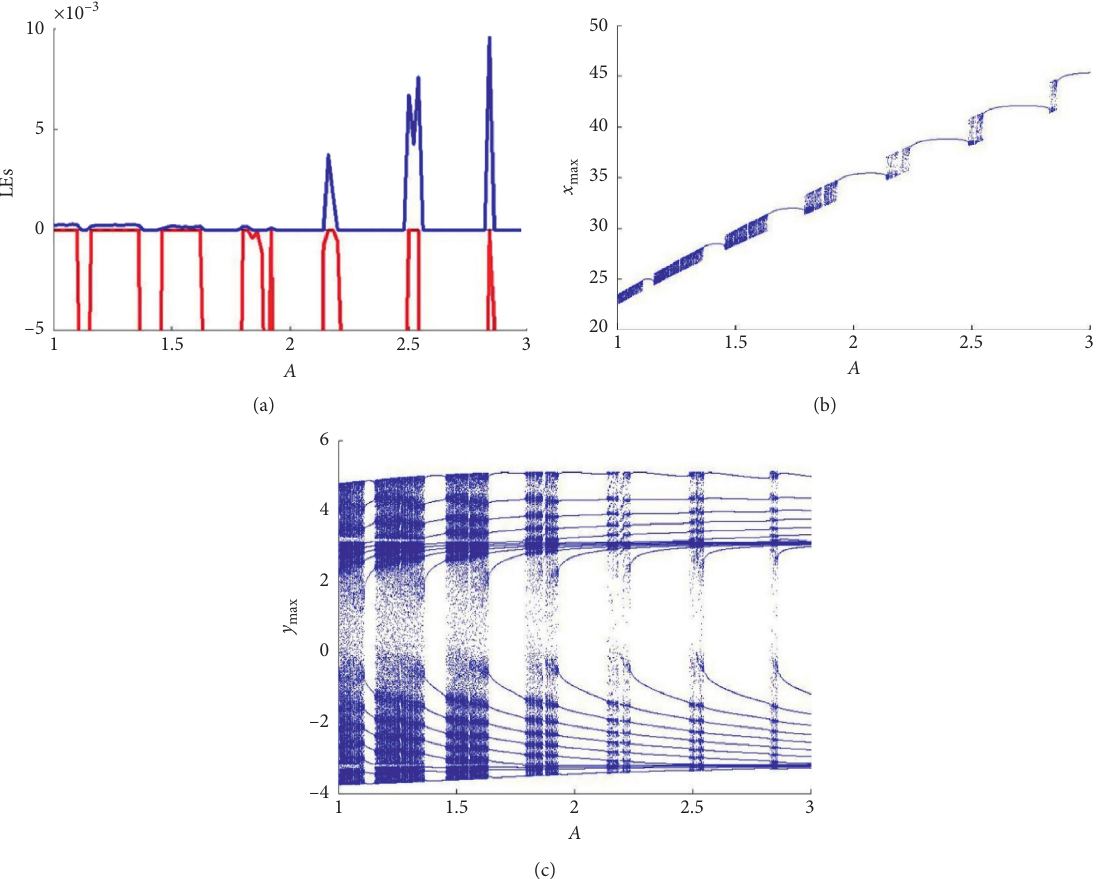
Figure 2: Lyapunov exponents and bifurcation diagrams are related to parameter A for w � 0 . 8 when the initial conditions are set ( 0 . 01 , 0 ) . (a) The two largest Lyapunov exponents are plotted and zoomed. Therefore, the third, which is negative (and has the largest absolute value), and also parts of the second cannot be seen for better visualization. (b) The local maximums of the x variable time series. (c) The local maximums of the y variable time